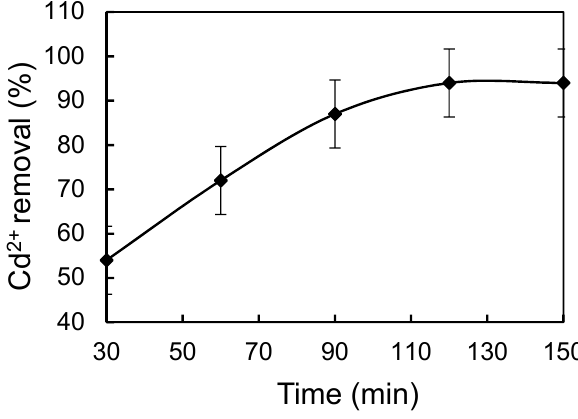
Figure 2. Effect of time of chitosan modification on Cd 2+ removal.